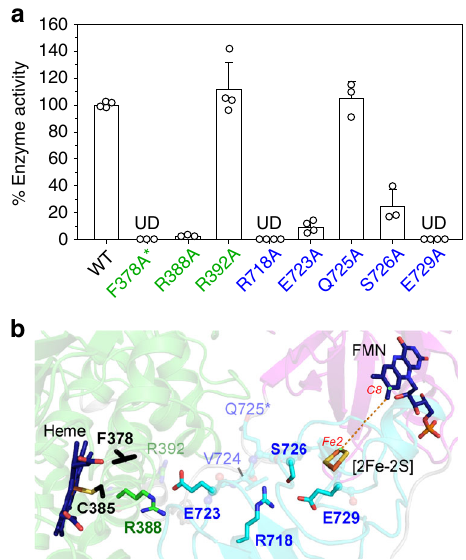
Fig. 3 Uncovering the hidden route. a The activity of Ala variants of several residues that are located between [2Fe-2S] and heme was measured. Triplicate or quadruple assay was performed in each independent experiment and the average (mean) and standard error (standard deviation, s.e.m.) for each group were calculated. Three independent experiments were conducted and similar results were yielded. The relative enzyme activity of each variant is presented as a percentage of the wild-type enzyme. The corresponding data points are displayed as dots. The sample size is 4 for WT, R392A, R718A, E723A, and E729A, and is 3 for F378A, R388A, Q725A, and S726A. UD, undetectable. Asterisk indicates that F378A lacked CO-binding capacity. Source data are provided as a Source Data fi le. The residues that may play a role in enzyme activity are highlighted and shown in ( b ). Residue F378 and C385 that may be required to bind to the heme are colored in black. The labels and color schemes of ( b ) are the same as in Fig.